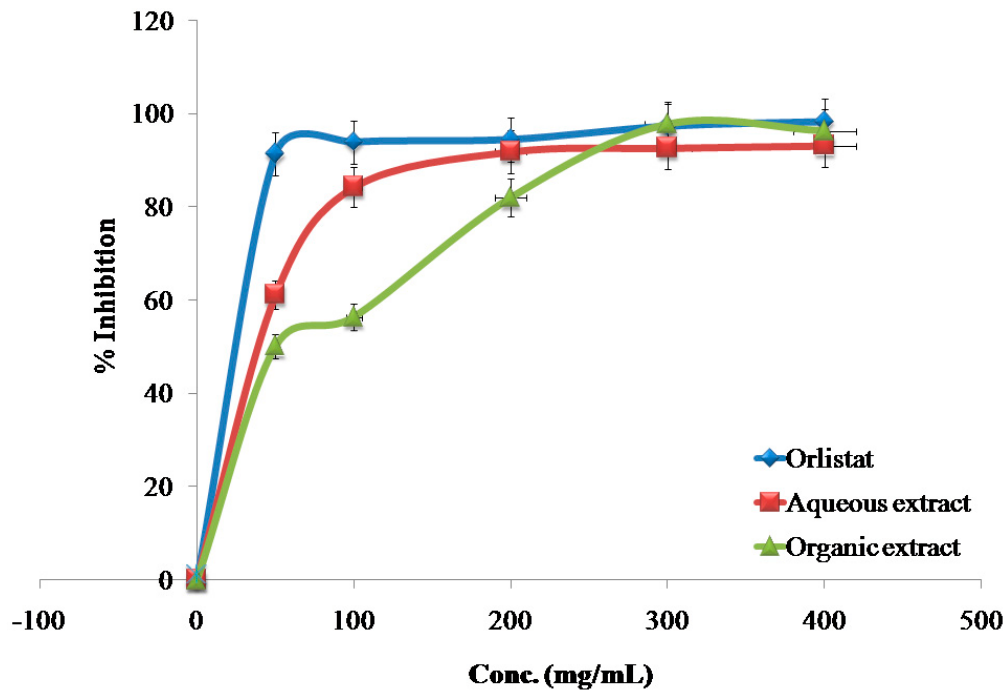
Figure 7. The inhibitory effects of the aqueous and organic extracts of R. coriaria and Orlistat on the activity of porcine pancreatic lipase.